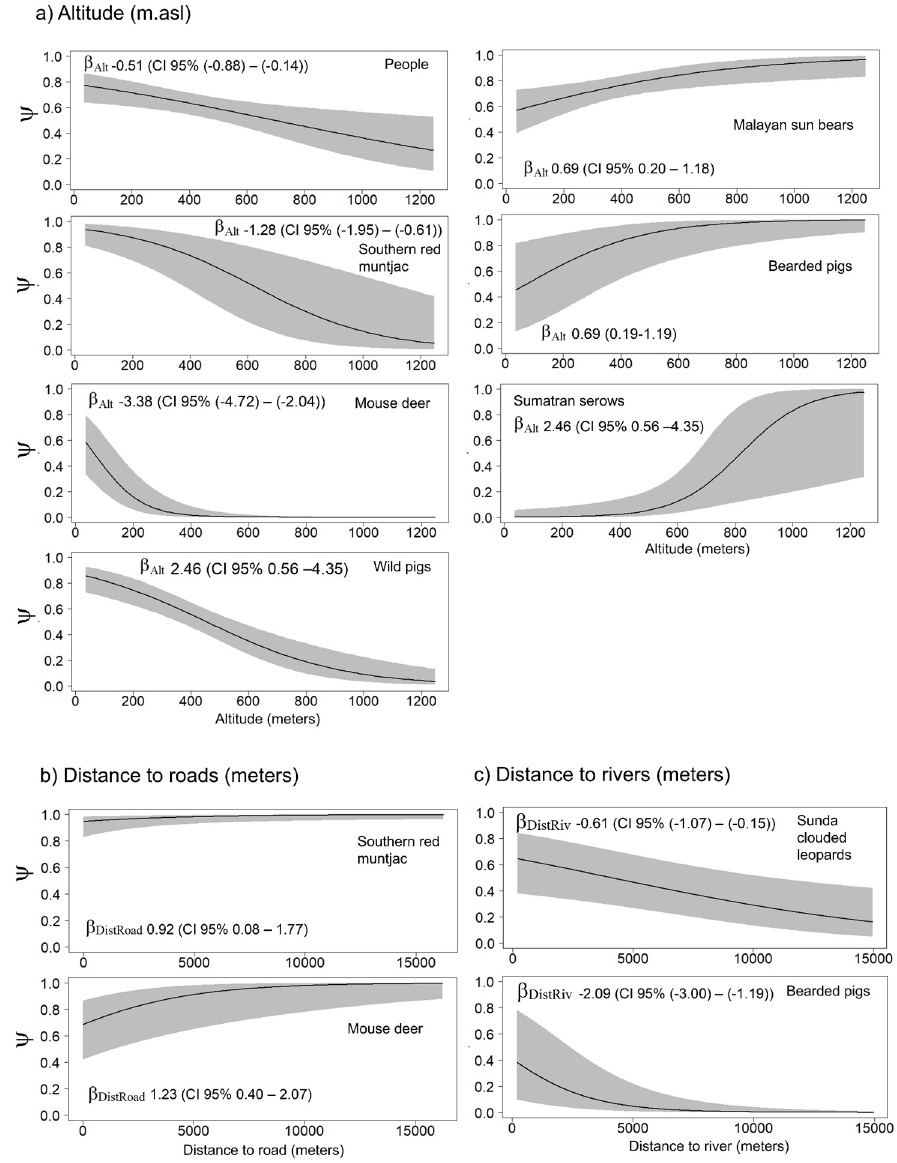
Fig 3. Relationships of habitat covariates to the probability of occupancy for all study sites as selected from models with the smallest AIC c . Correlations are based on a robust β as indicated by the ± 95% CI not overlapping